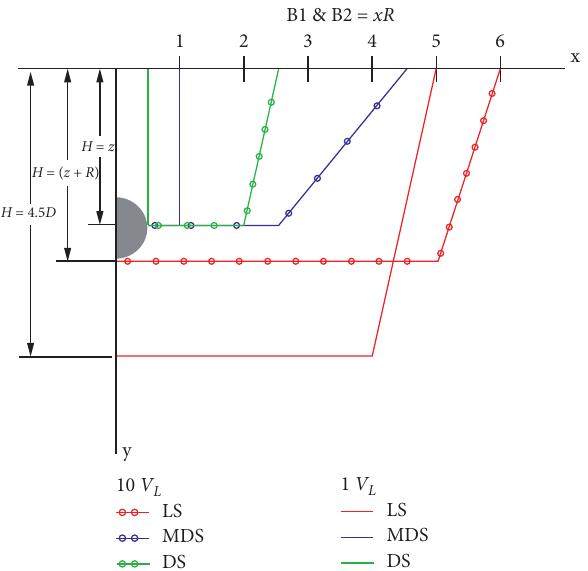
Figure 10: Influence zones for small tunnel ( D � 3m). B1 and B2 are top and bottom width of influence zone measured in terms of tunnel radius “ R .” “ H ” is height of influence zones in terms of tunnel diameter “ D .”